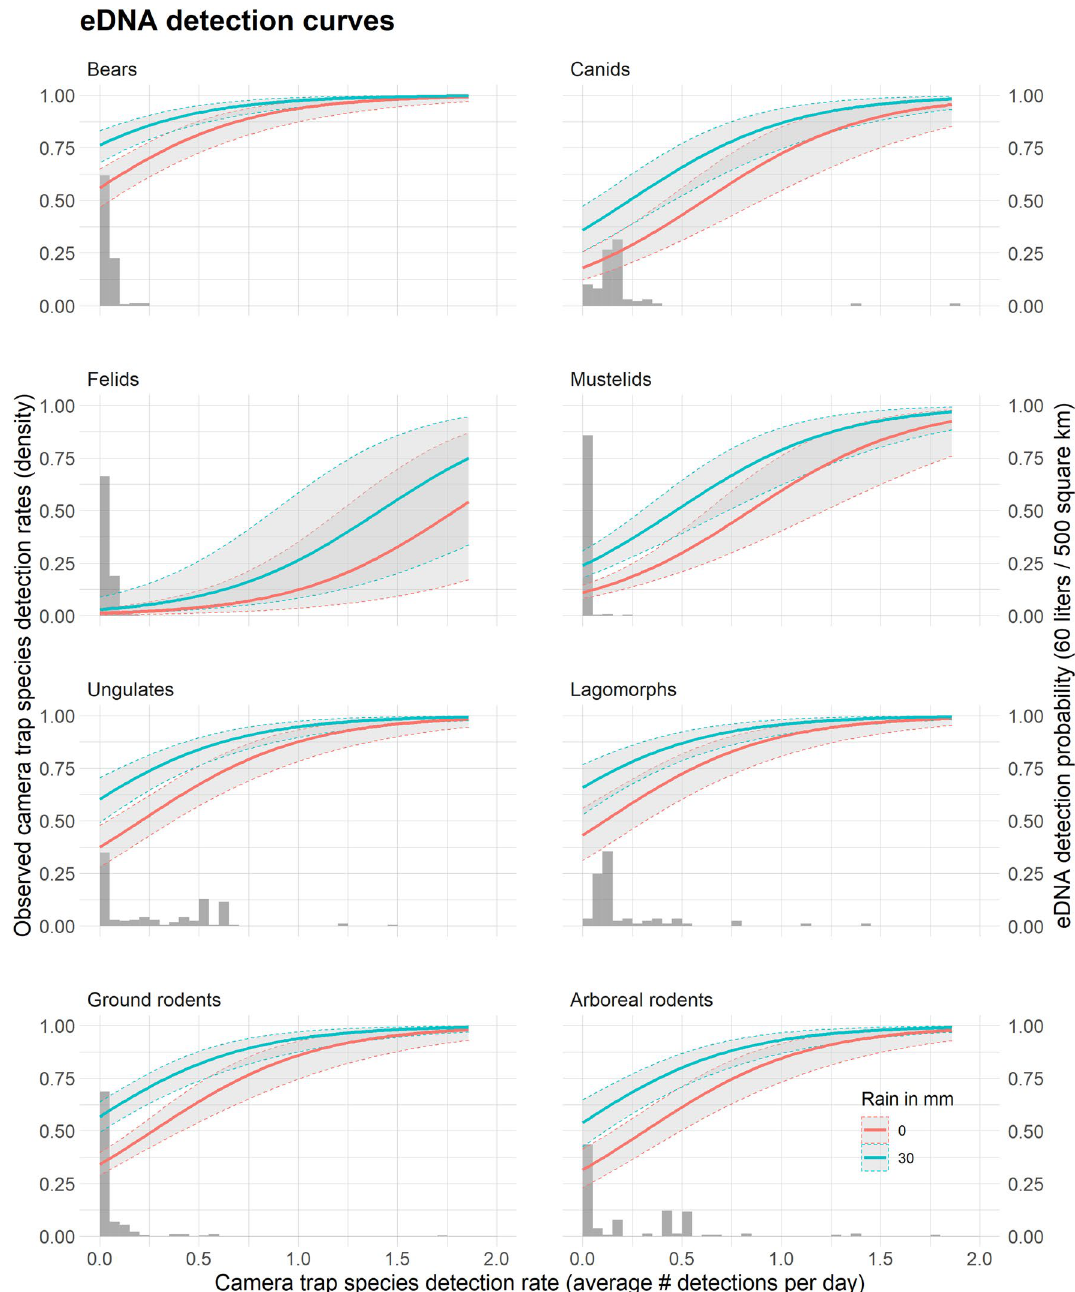
Figure 4. Taxonomic eDNA detection curves. Relationship between the eDNA detection probability at a site (y-axis, right side), the average camera trap detection rate at the catchment (x-axis), and the rain the day prior to sampling (no rain in red, 30 mm in blue). Curves are calculated for 60 L of water filtered from a stream draining a 500 km 2 catchment. The figure shows the mean predicted value (solid lines) and associated standard errors (± SE, grey areas), calculated using the parameter estimates from the model with the lowest AICc (Supplementary Tables 2a,b). The histograms represent the observed density distribution of the average camera trap detection rates associated with eDNA sampling sites (y-axis, left side). For instance, on the “Ground rodents”, the histogram indicates that more than 75% of the eDNA sampling locations were associated with a catchment where on average across all camera trap located in the catchment, less than 0.2 ground rodents were detected every day, or one ground rodent detected every 5 days. Data from 2018 and 2019 are